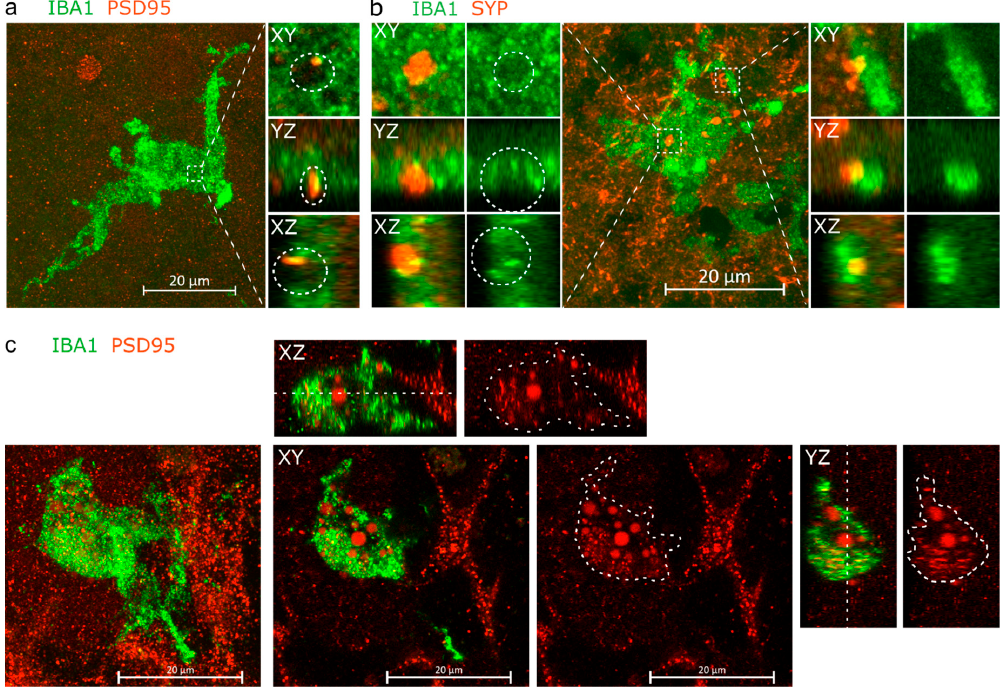
Figure 2. IBA1+ cells are in intimate proximity with neurons. ( a ) Orthogonal projection and orthog- onal dissections of PSD95+ post-synaptic material embedded within a pocket on the surface of an IBA1+ cell. ( b ) Instances of SYP+ presynaptic material embedded within a pocket on the soma of IBA1+ cell and partially internalised by process of the cell. ( c ) Orthogonal projection, with the XY, XZ and YZ planes showing PSD95+ material located within the IBA1+ cell. The white cut line crossing the IBA1+ cell on the XZ and XZ planes marks the Z-coordinate of the XY plane, while cut line areas drawn on the red-channel images overlay perimeter of the IBA1+ cell. Panels a and b come from organoids of the iPCS line MAD6, while panel c comes from